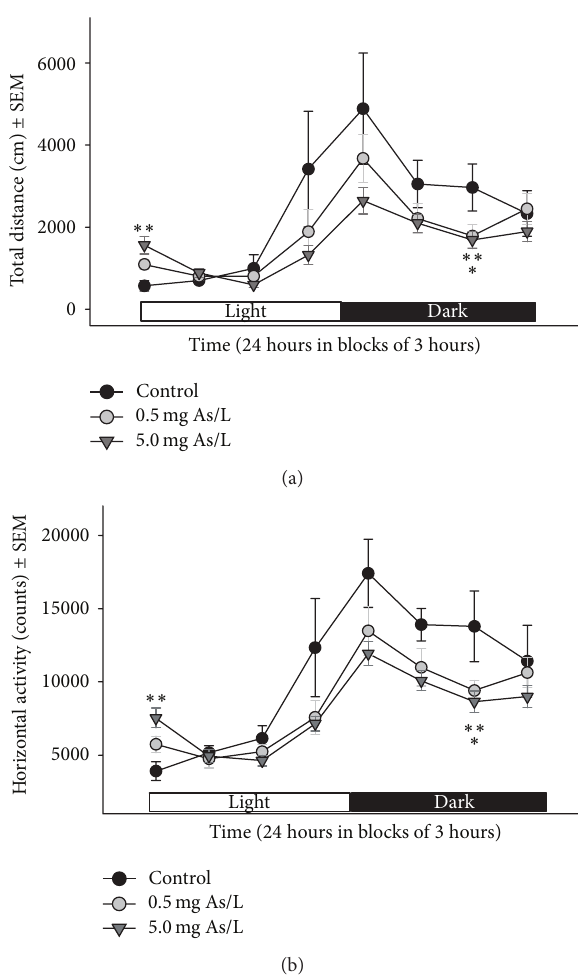
Figure 2: Effect of the chronic exposure to 0.5 or 5.0 mg As/L of drinking water on total distance (a) and horizontal activity (b). Spontaneous locomotor activity was recorded over the course of a 24-hour dark/light cycle at six months of As exposure. ∗ and ∗∗ denote differences between the 0.5 and 5.0 mg As/L groups, respectively, from the control group, 𝑝 < 0.05